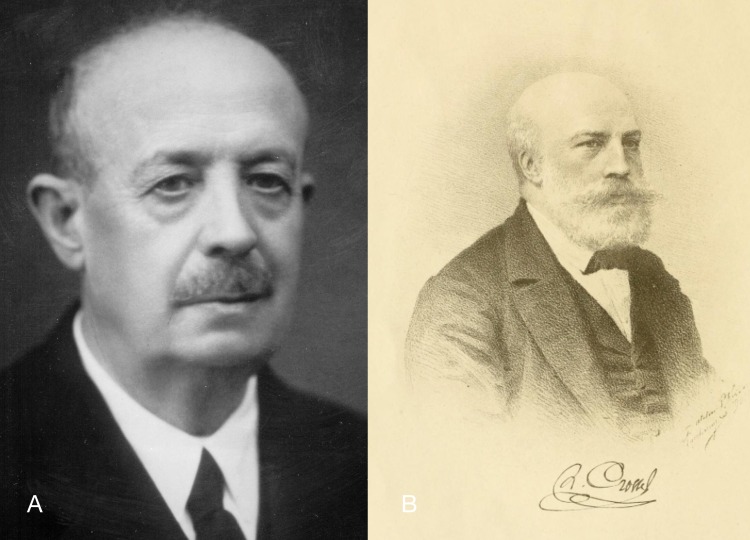
Portraits of persons mentioned in this study.(A) Florentino Azpeitia, unknown date (photo R. Araujo); (B) Hippolyte Crosse, unknown date (Tual & Fischer, 1899).